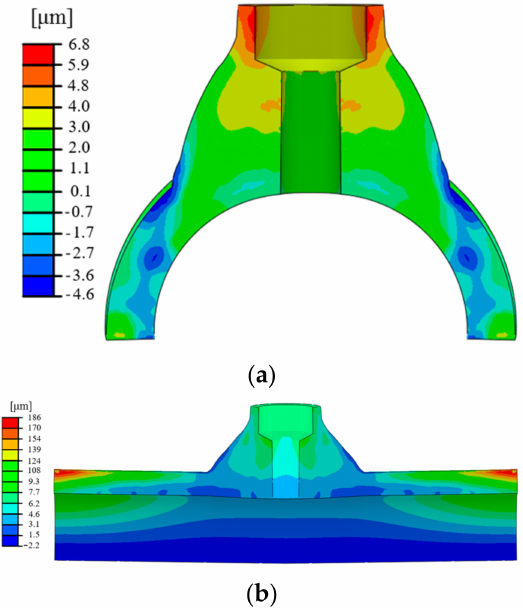
Figure 6. Displacement distribution on the two cut surfaces: ( a ) displacement distribution for the section cut along the circumferential direction; ( b ) displacement distribution for the section cut along the longitudinal